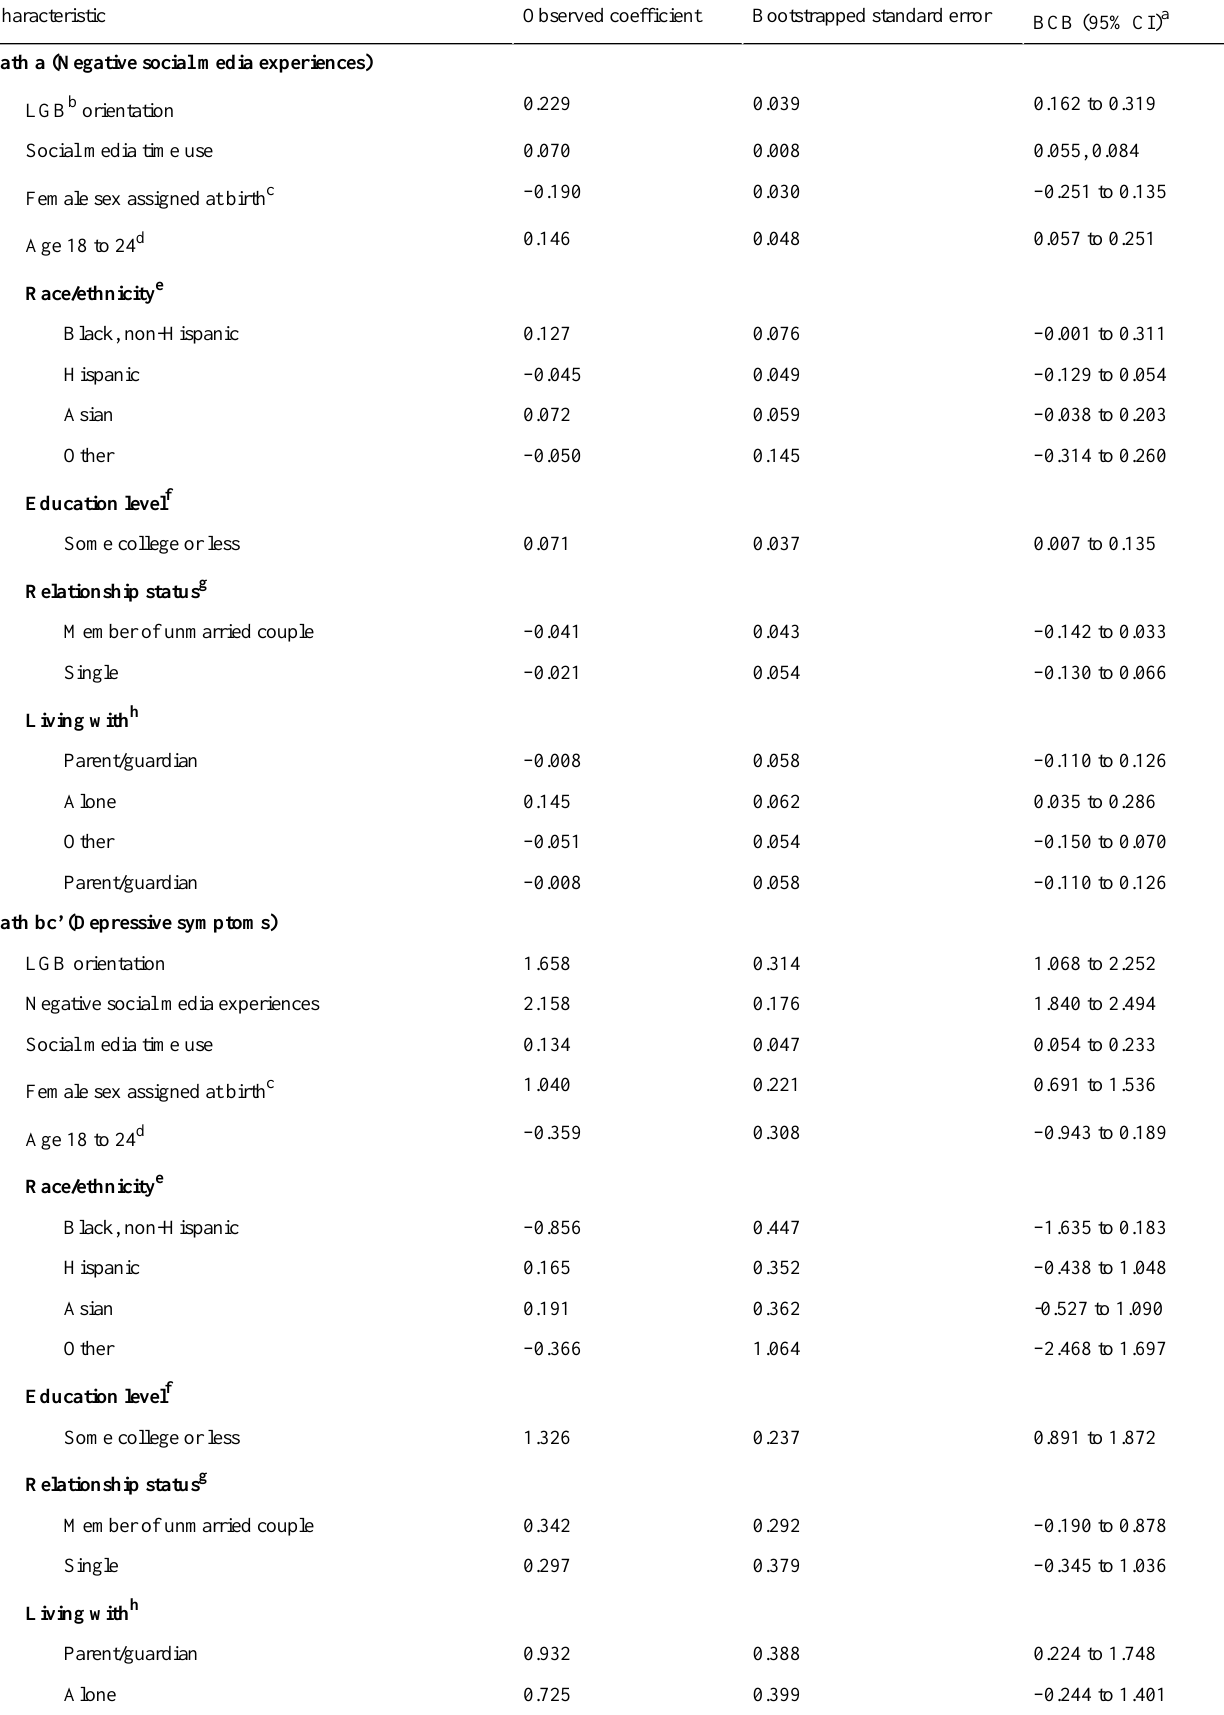
Table 3. Generalized structural equation model (GSEM) results for conditional indirect effects of LGB orientation on depressive symptoms (path ab-c’ model)